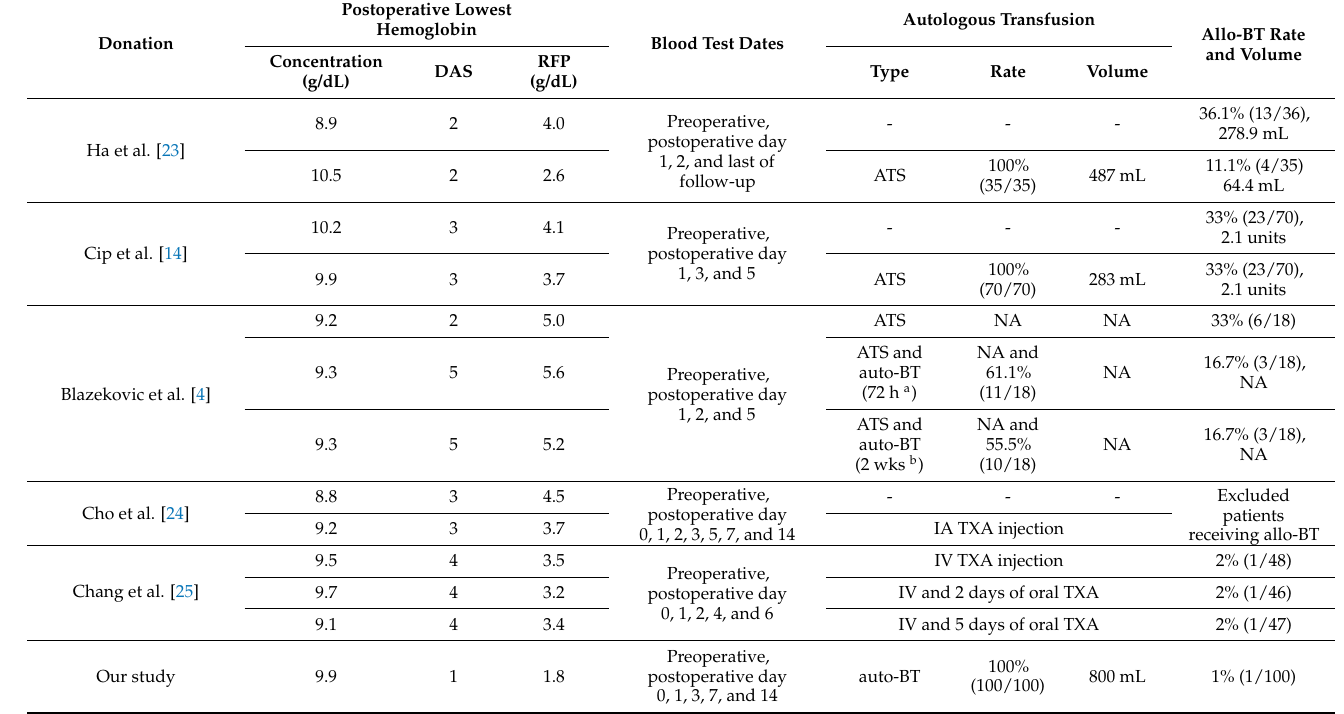
Table 3. A comparison of the current study results with the